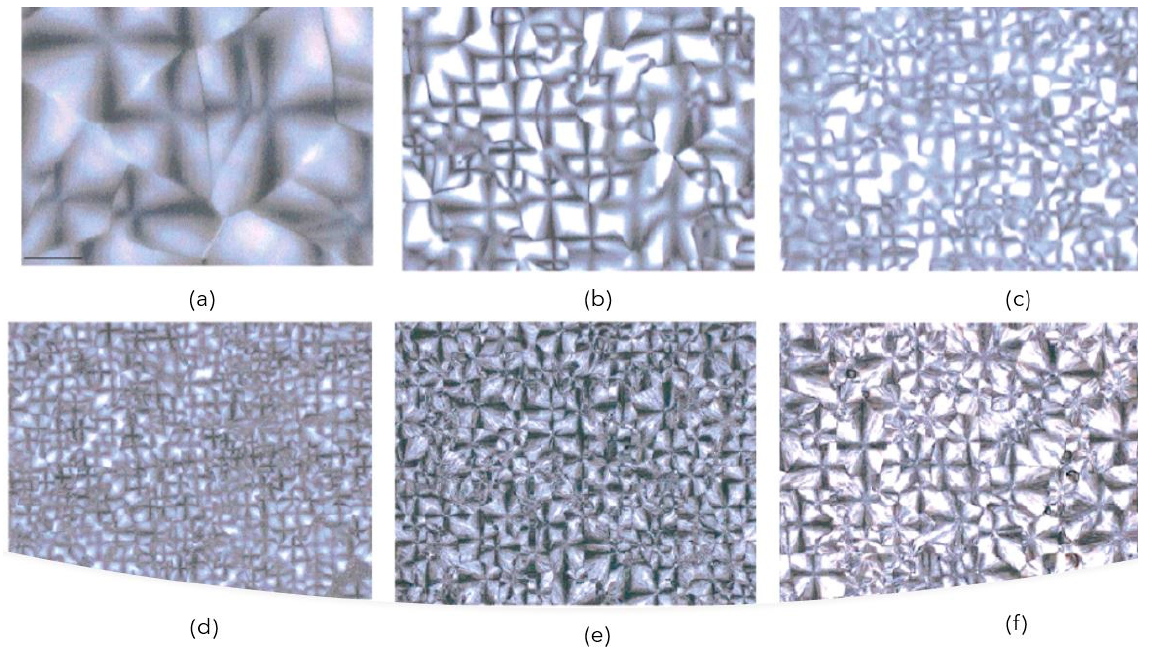
Figure 7. Polarizing optical micrographs of succinate-based copolymers: ( a ) PBS; ( b ) PBSA, adipate unit (mol%) = 21%; ( c ) PBSA, adipate unit (mol%) = 41%; ( d ) PBSA, adipate unit (mol%) = 49%; ( e ) PBSA, adipate unit (mol%) = 80%; ( f ) PBA. [Reprinted with permission from Reference [6] Copyright 2001 Wiley].